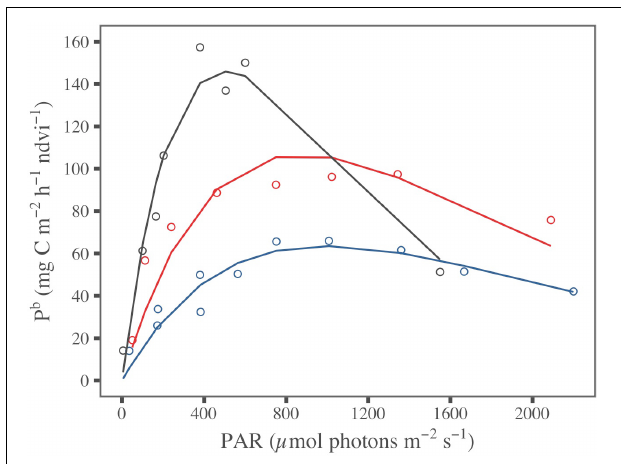
FIGURE 5 | Measured (dot) and predicted (line) biomass specific productivity (P b ) standardized by NDVI, fitted with the Eilers and Peeters (1988) P–E model for the three periods of investigation: March (blue), May (gray), and July (red).